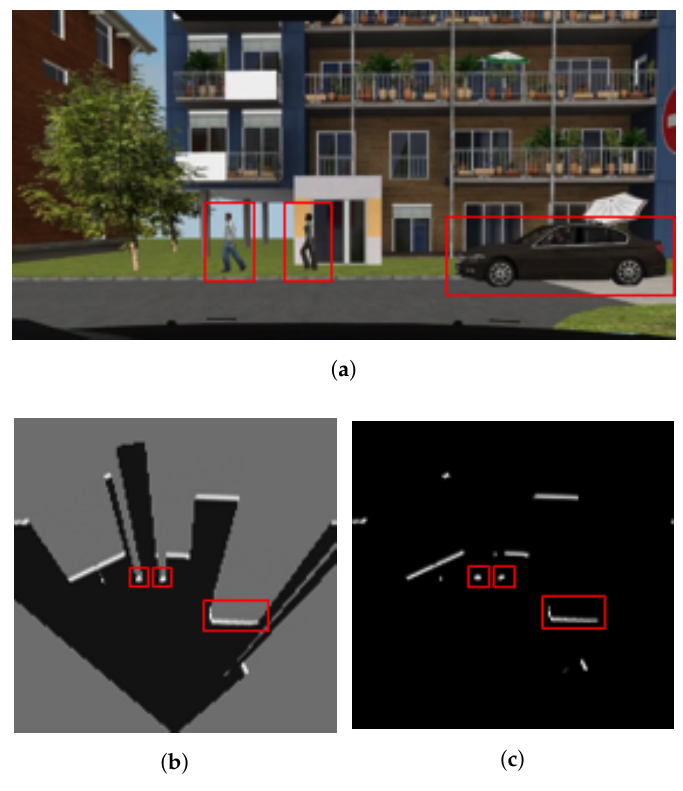
Figure 6. ( a ) Snapshot of a scene taken from the dataset where pedestrians and vehicles are detected (red boxes); ( b ) Image from camera, occupancy grid combining the 4 layers of the LiDAR; ( c ) the resulting set of footprints at the